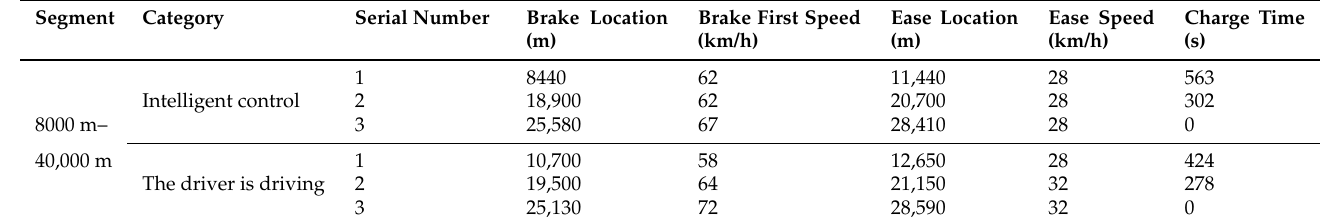
Table 7. Record of the cycle braking on the long